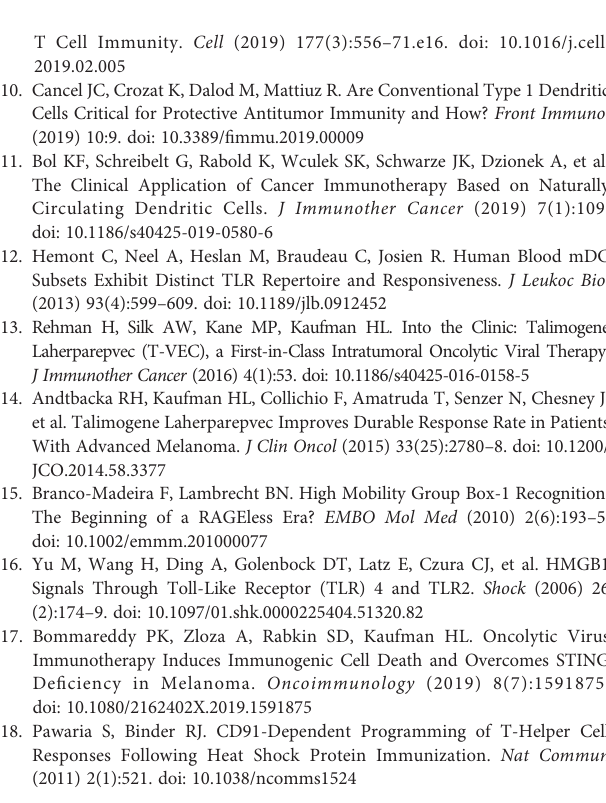
Supplementary Figure 1 | Effect of supernatant from T-VEC-treated melanoma cells on BDCA-1+/BDCA-3+ myDC. BDCA-1+/BDCA-3+ myDC were incubated for 24h with supernatant from untreated 624-mel cells, supernatant from 624-mel cells treated with T-VEC (MOI 1) during 24h, supernatant from 624-mel cells treated with T-VEC (MOI 1) during 48h, supernatant from untreated 938-mel cells, supernatant from 938-mel cells treated with T-VEC (MOI 1) during 24h or supernatant from 938-mel cells treated with T- VEC (MOI 1) during 48h. After 24h, the phenotype of the DC was analyzed by fl ow cytometry. (A) Results gated on BDCA-1+ DC. (B) Results gated on BDCA-3+ DC. On the left y-axis (red symbols) the percentage of expression of each marker is depicted and on the right y-axis (blue symbols) the mean fl uorescence intensity (MFI) is plotted. Each symbol represents the result of an independent experiment, and the line represents the median. Supplementary Figure 2 | Effect of heat inactivation of supernatant from T-VEC- treated melanoma cells on BDCA-1+/BDCA-3+ myDC cytokine secretion. BDCA-1 +/BDCA-3+ myDC were incubated for 24h with supernatant from untreated 938- mel cells, supernatant from 938-mel cells treated with T-VEC (MOI 1) during 24h or supernatant from 938-mel cells treated with T-VEC (MOI 1) during 48h. The supernatant was either added as such or after a heat-inactivation step. After 24h, the supernatant from the cultures was harvested and cytokine content was analyzed using MesoScale Diagnostics assays. The cytokine concentrations were normalized to the condition where the cells were incubated with the supernatant of untreated tumor cells (both for 624-mel and 938-mel). Each symbol represents the result of an independent experiment, and the bars indicate the mean ± SD. Supplementary Figure 3 | Effect of T-VEC on BDCA-1+/BDCA-3+ myDC. BDCA-1+/BDCA-3+ myDC wereincubated with T-VEC (MOI 1), heat-inactivated T- VEC (MOI 1) or left untreated. After 24h the phenotype of the DC was analyzed by fl ow cytometry. (A) Results gated on BDCA-1+ DC. (B) Results gated on BDCA-3+ DC. On the left y-axis (red symbols) the percentage of expression of each marker is depicted and on the right y-axis (blue symbols) the mean fl uorescence intensity (MFI) is plotted. Each symbol represents the result of an independent experiment, and the line represents the